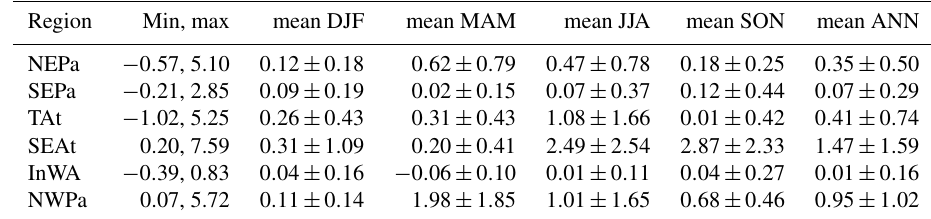
Table 6. Estimated SW TOA DARE OWC (Wm − 2 , setting is Case IV of Table 4) in each region of Table 5. Region Min, max mean